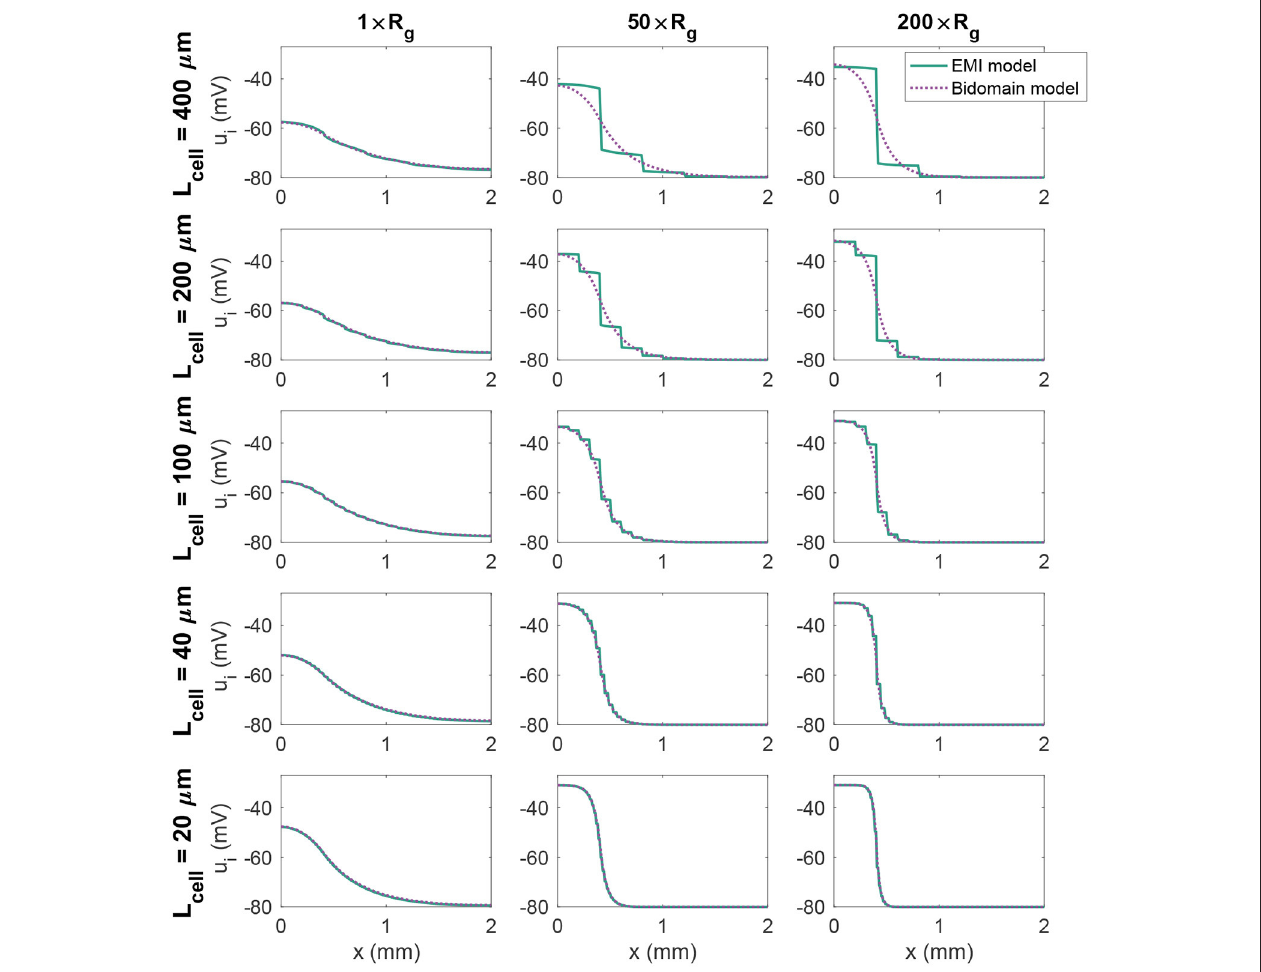
FIGURE 3 | Intracellular potential, u i , at time t = 20 ms in EMI model and bidomain model simulations using a passive membrane model (Equation 74) and the default parameter values specified in Table 1 , except that the value of R g is increased by the factor indicated by the column titles. In addition, the cell length ( L cell ) is varied as described for each row of